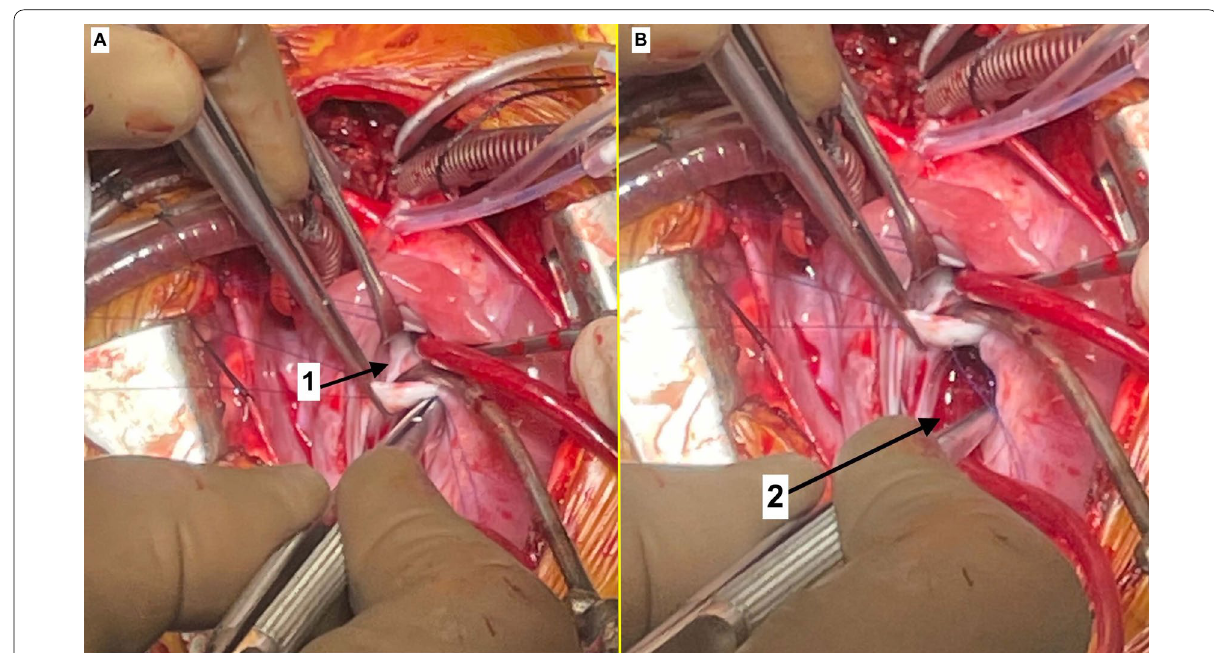
Fig. 3 Intra-operative images. A The membranous partition (1) of LA as seen through the PFO. B The dilated coronary sinus